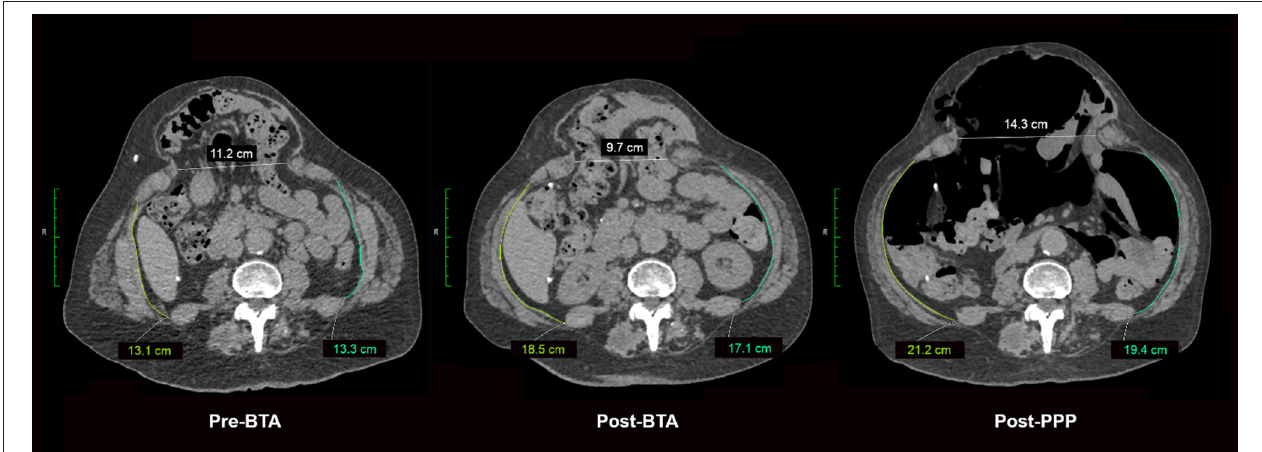
FIGURE 3 | Axial CT images demonstrating progressive changes in abdominal circumference and hernia defect measurement changes (Baseline/Pre-BTA, Post-BTA and Post PPP). Measurements taken from the same vertebral level on each occasion.